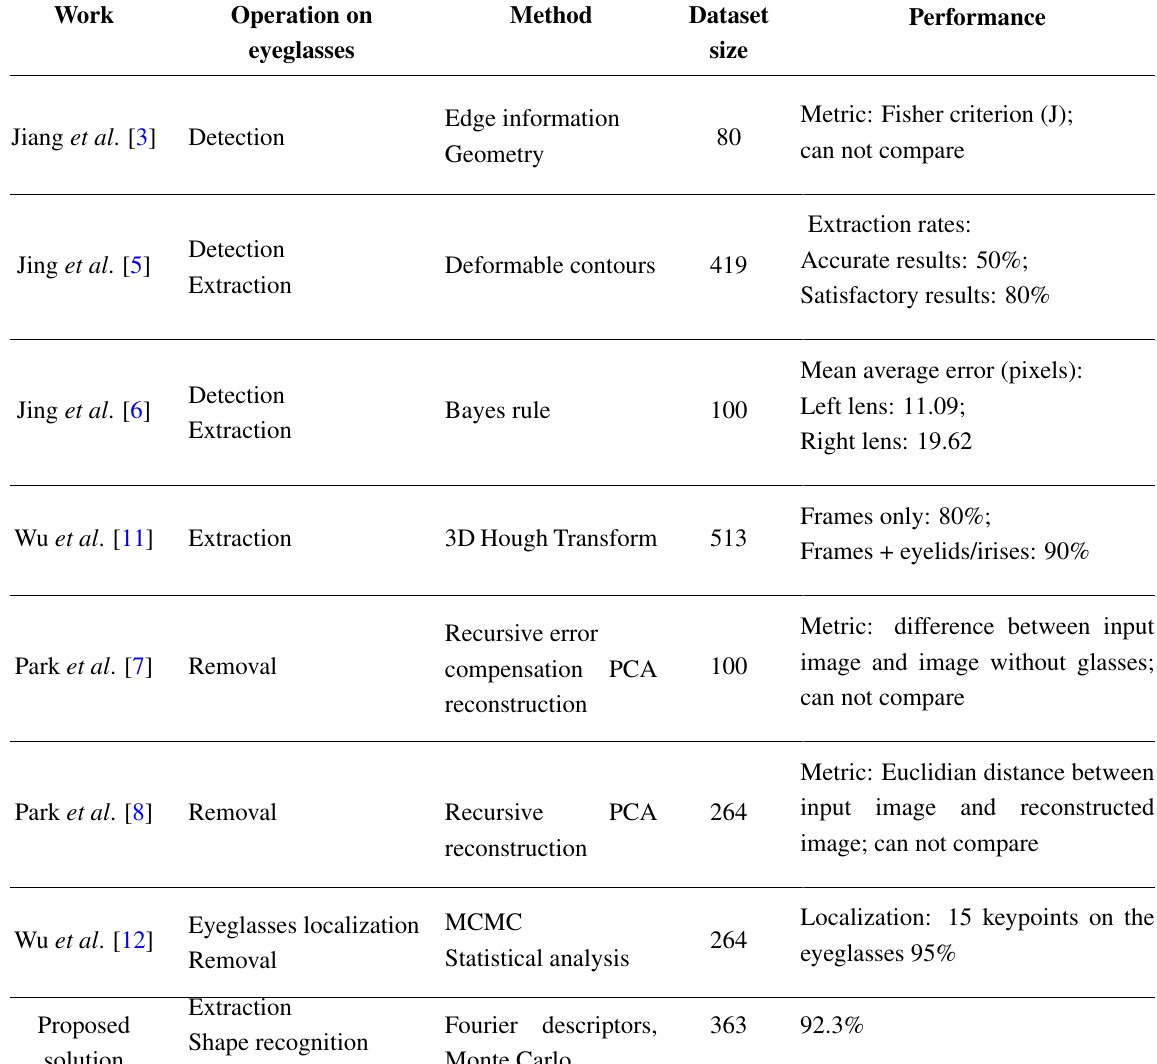
Table 3. Comparison of the proposed method with related